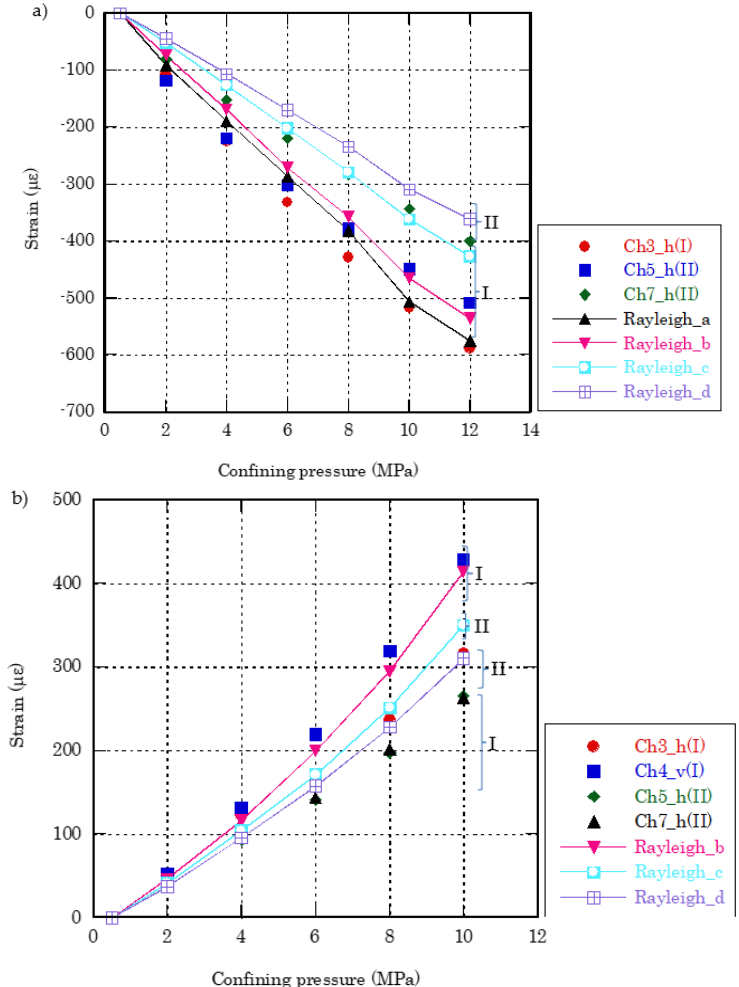
Figure 16. Rayleigh frequency shift-to -strain conversions for the heterogeneous Tako core vs. hoop strain gauge measurements: ( a ) increasing confining pressure; ( b ) increasing pore pressure (including vertical strains by Ch4 in the coarse-region). I—coarse-grain region; II—fine-grain region.